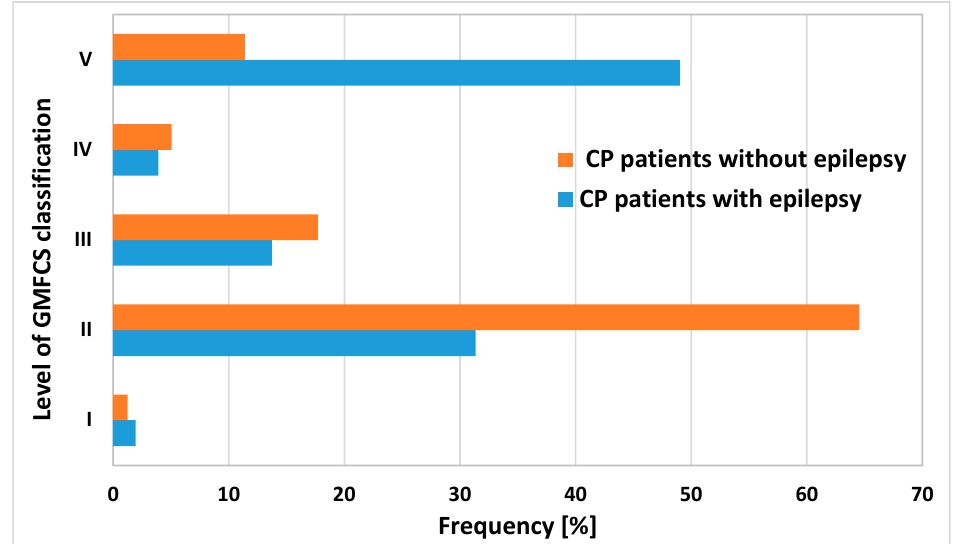
Figure 2. The distribution of GMCSF levels in children with and without epilepsy. GMFCS—Gross Motor Function Classification Scale; CP—cerebral palsy.